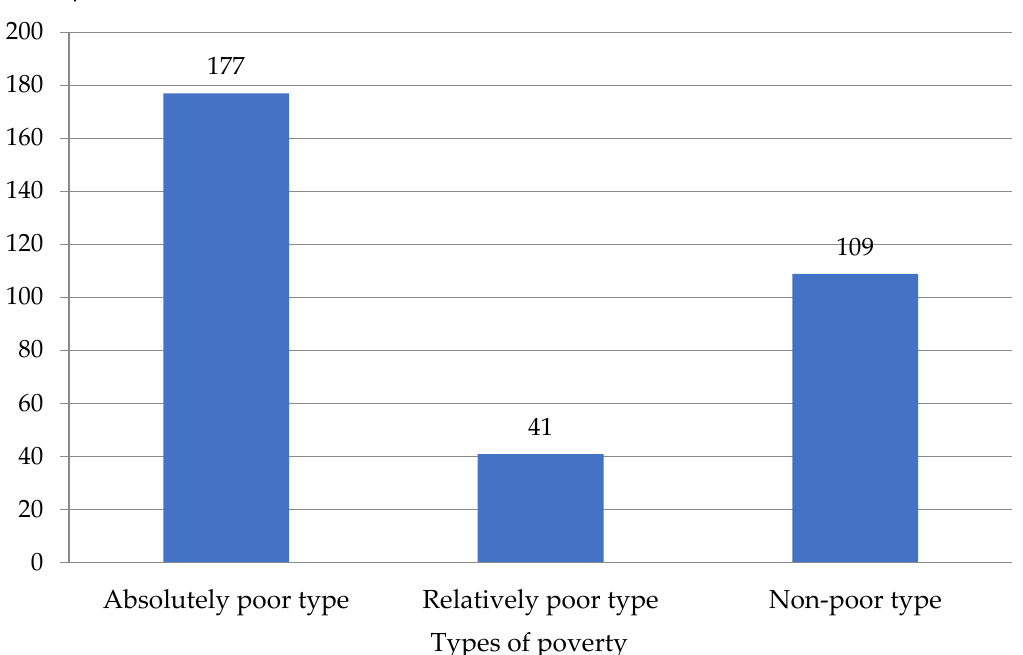
Figure 3. Statistics on the frequency of farmers ’ poverty types.